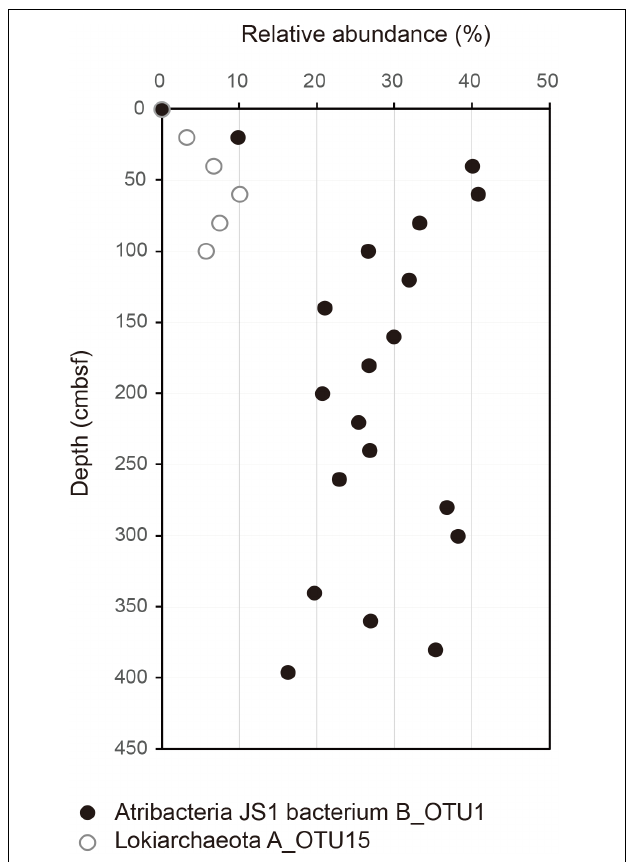
FIGURE 2 | Relative abundance of B_OTU1 of JS1 and archaeal OTU, A_OTU15 along the depth of the core. B_OTU1 is the most predominant OTU of JS1 and A_OTU15 is an archaeal OTU with a significant correlation with B_OTU1. Closed circles indicate JS1 OTU, B_OTU1, and open circles indicate archaeal OTU A_OTU15 of